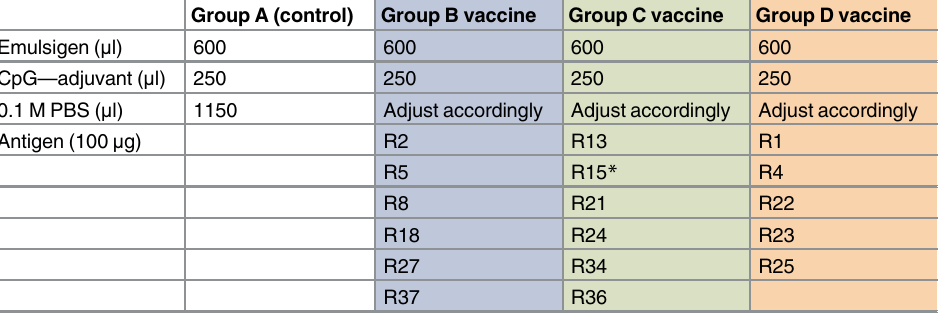
Table 2. Vaccine formulation for a single 2 mL dose. “ R ” is denoted for rank of gene or protein. The vac- cine for group A (placebo/control group) did not contain antigens. The vaccine for groups B, C and D con- tained antigens (R2, R5, R8, R18, R27, R37), (R13, R15, R21, R24, R34, R36) and (R1, R4, R22, R23, R35) respectively. Emulsigen and CpG oligodeoxynucleotides were used together to achieve a balanced Th1/Th2 immune